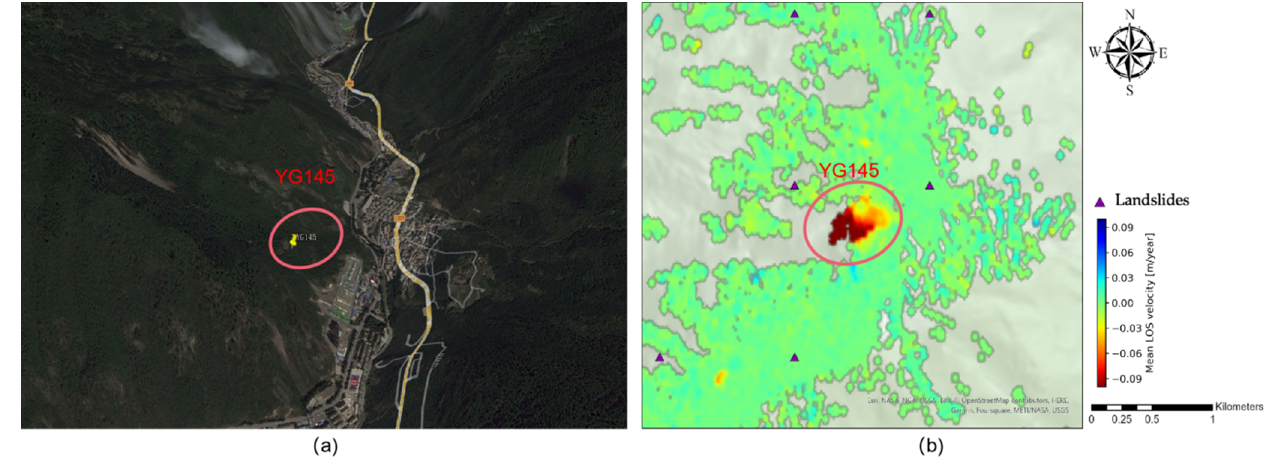
Figure 8. (a) The optical image of YG145 landslide in Zhangzha. ( b ) Surface deformation results for YG145 landslide. This landslide was located at the back of the Jiuzhaigou Hotel in Zhangzha, with a maximum slope deformation greater than 100 mm/year.